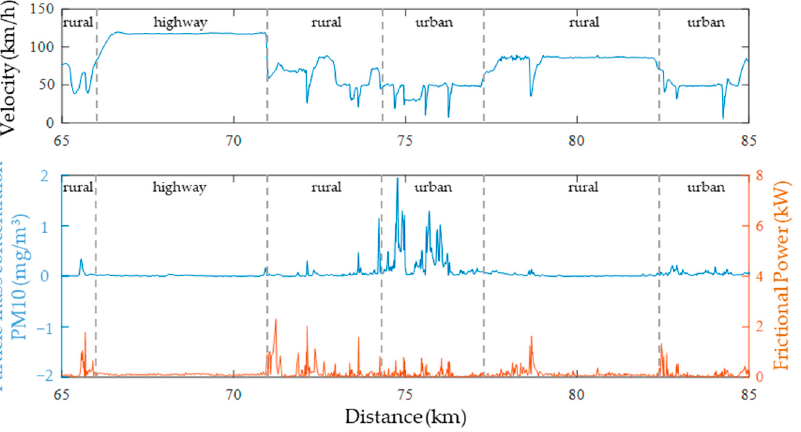
Figure 10. Correlation between driving speed, converted friction power and measured particulate mass concentration to clarify the influence of emissions from external sources–RDE test cycle.